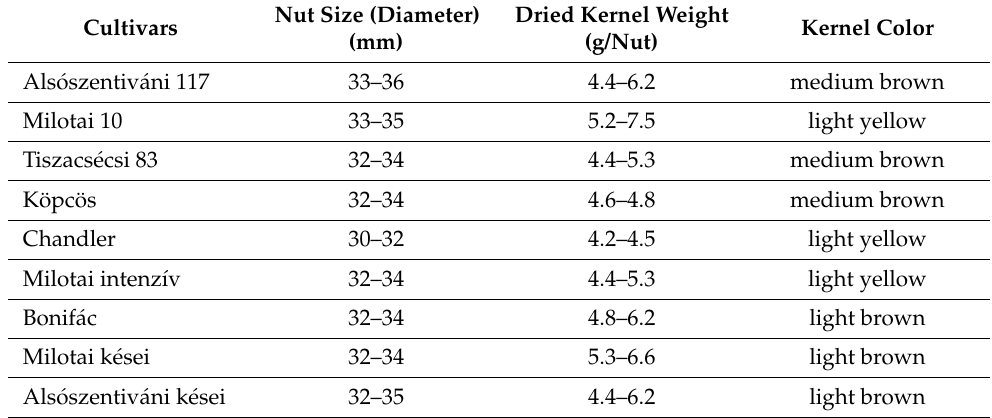
Table 3. Detailed phenological descriptions of the examined walnut cultivars in this study [55].